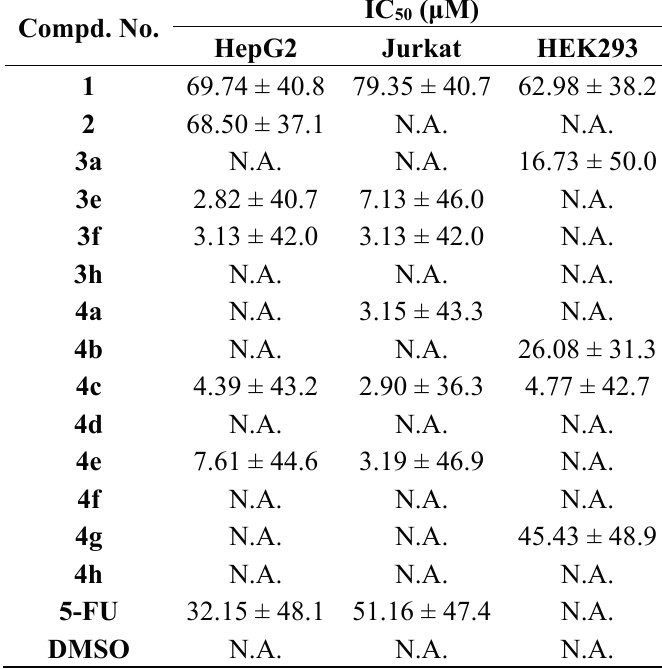
Figure 5. Dose-dependent responses of hydrazide-hydrazone derivatives in three cell lines. Each line represents the mean of three different experiments representing the % of mortality as compared to mock treated control cells. Table 3. In vitro cytotoxicity activity of the synthesized compounds in two cancer and one normal cell line(s) as measured with MTT assay